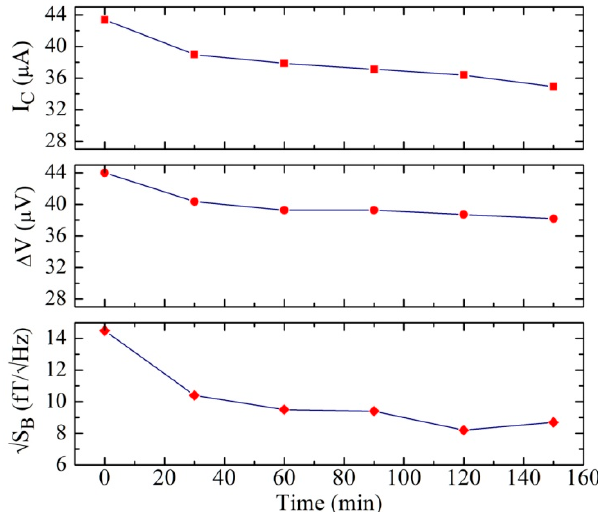
Figure 6. Critical current (top), voltage swing (middle), and white magnetic field noise of a SQUID magnetometer as a function of the annealing time for a fixed annealing temperature (T a = 170 °C).